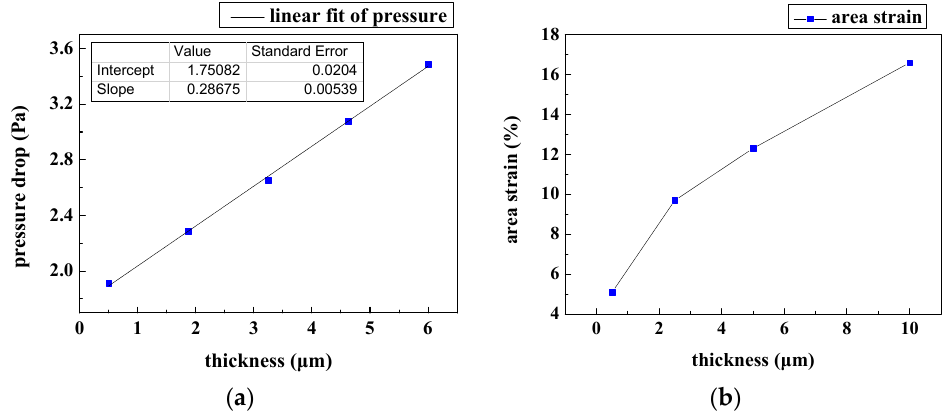
Figure 8. Effects of the thickness of slit-shaped patterned microfilters: ( a ) pressure drop between filtering films with different thickness; ( b ) area strain of WBCs passing through filtering films with different thicknesses.